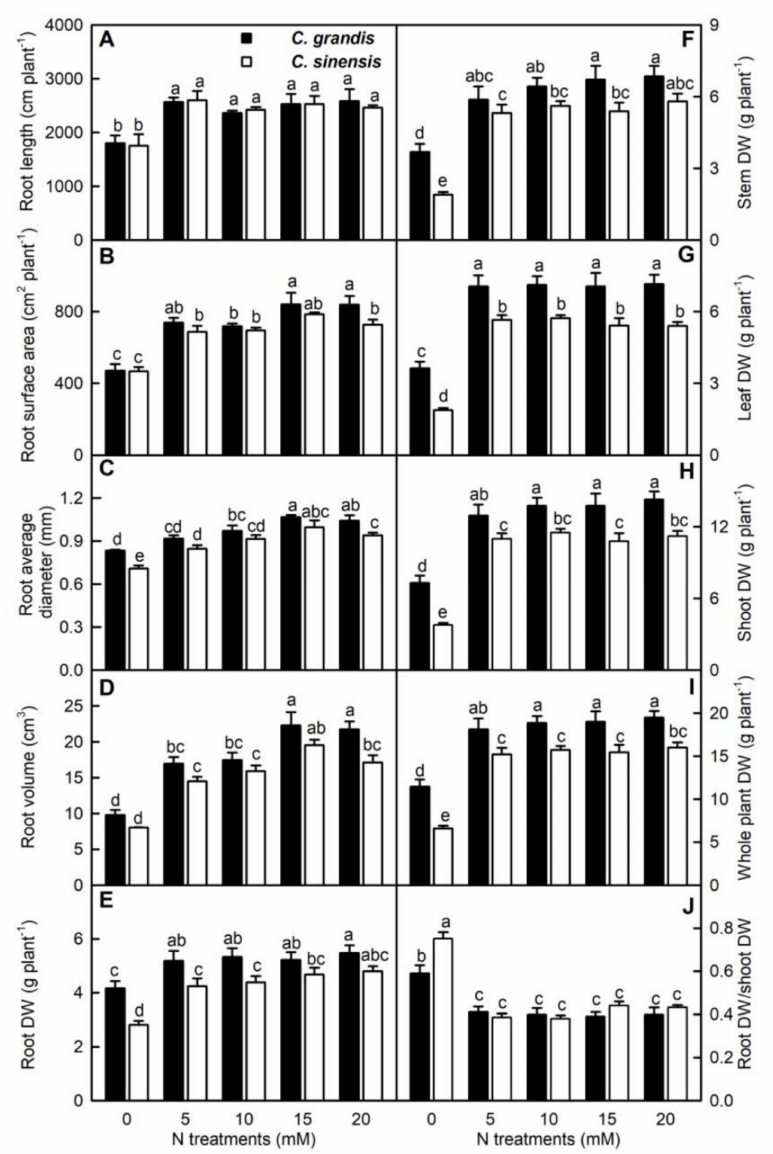
Figure 1. Effects of nitrogen (N) supply on mean ( ± SE, n = 3–4 for ( A – D ) or 12 for ( E – J )) root length ( A ), root surface ( B ), root average diameter ( C ), root volume ( D ), root dry weight (DW, ( E )), stem DW ( F ), leaf DW ( G ), shoot DW ( H ), whole plant DW ( I ) and root DW/shoot DW ratio ( J ) in Citrus grandis and Citrus sinensis seedlings. Different letters above the bars indicate a significant difference at p < 0.05. The same notation will be used in Figures 2–7 and